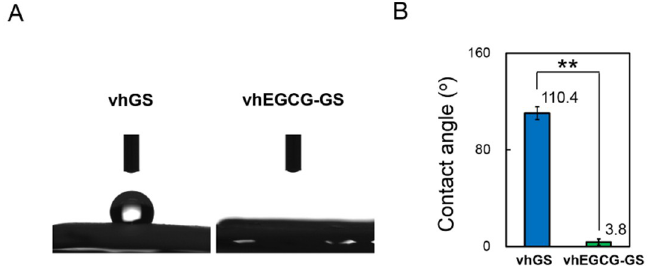
Figure 8. Water wettability of the membrane prepared from vhGS and vhEGCG-GS. ( A ) Macroscopic images. The water droplet was 1 μL. ( B ) Water contact angle of the membrane. Data were obtained at 15 s after the water drop. ** p < 0.01 (Student’s t test). The bar graph shows the mean with standard deviation ( n = 12). Numbers: means of contact angles.